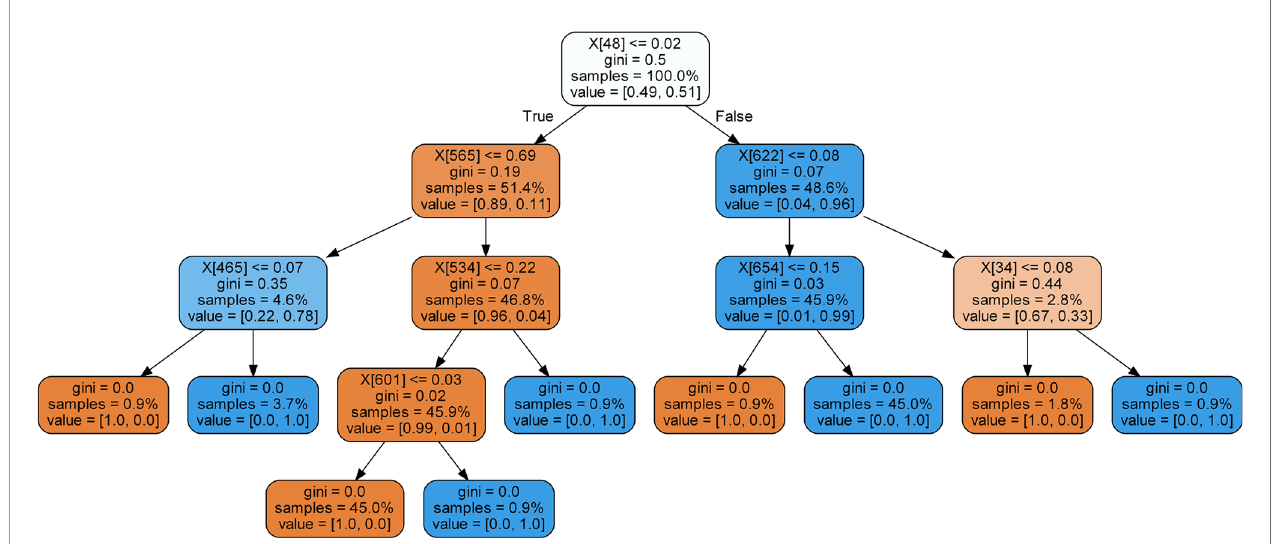
FIGURE 3 | Single decision tree structure diagram of random forest (RF)